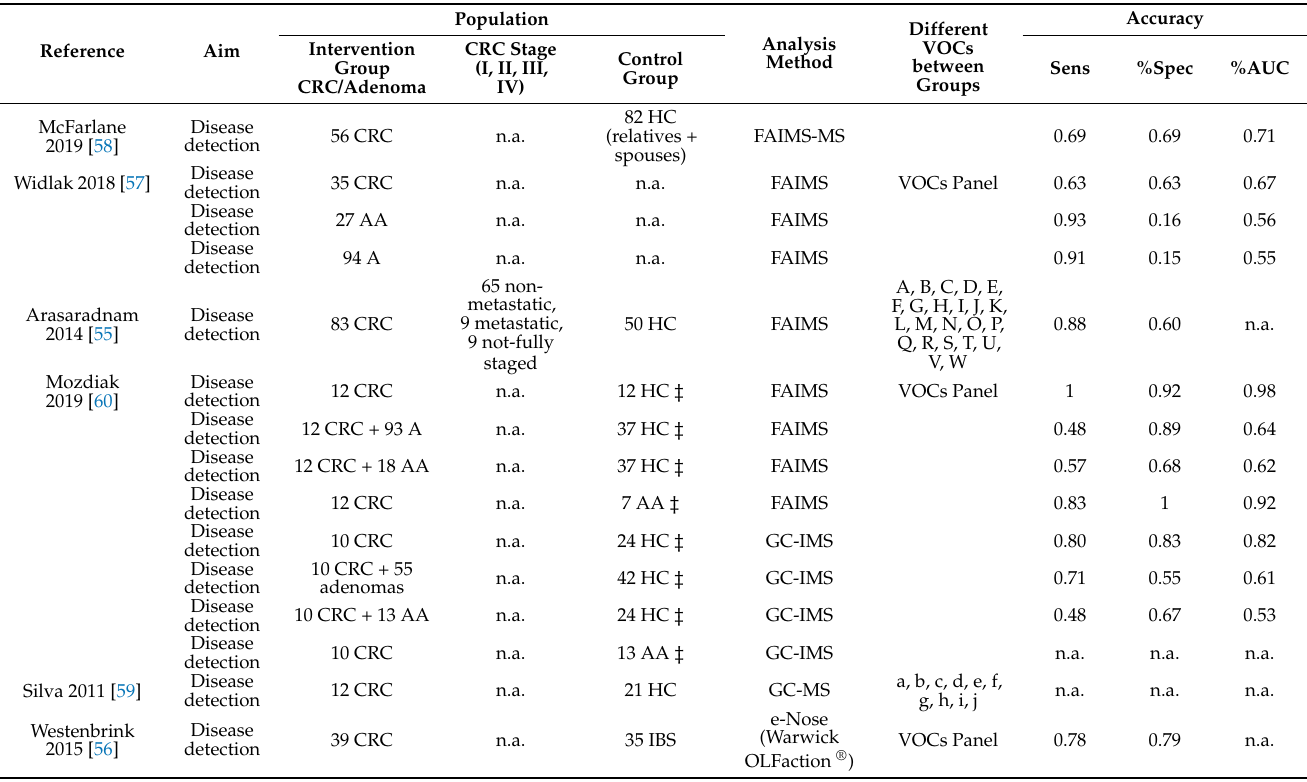
Table 4. Urinary VOCs and colorectal cancers or adenoma